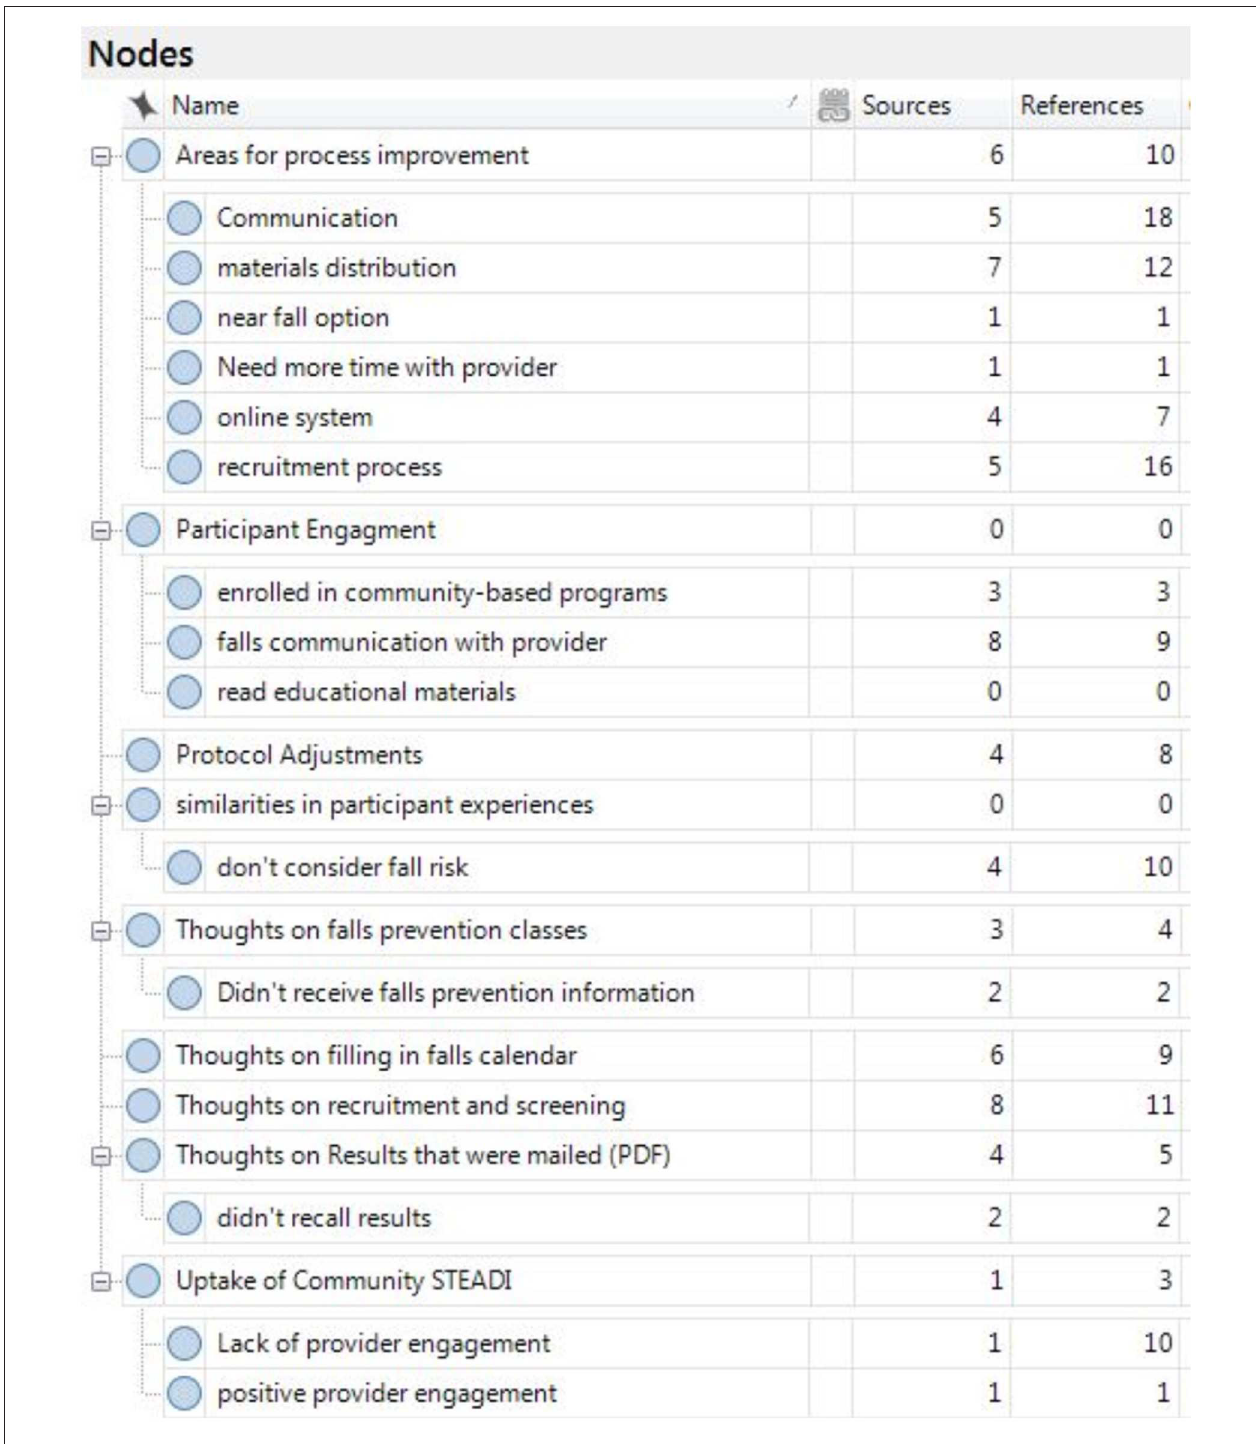
FIGURE 3 | Subcategories of a priori codes for thematic analysis of the focus groups.